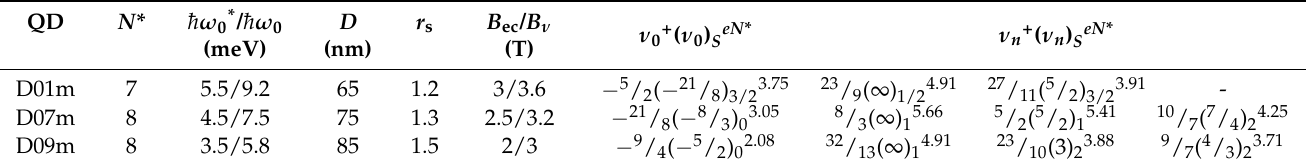
Table 1. Properties of anyon(magneto-electron) composites of InP/GaInP 2 quantum Hall puddles.